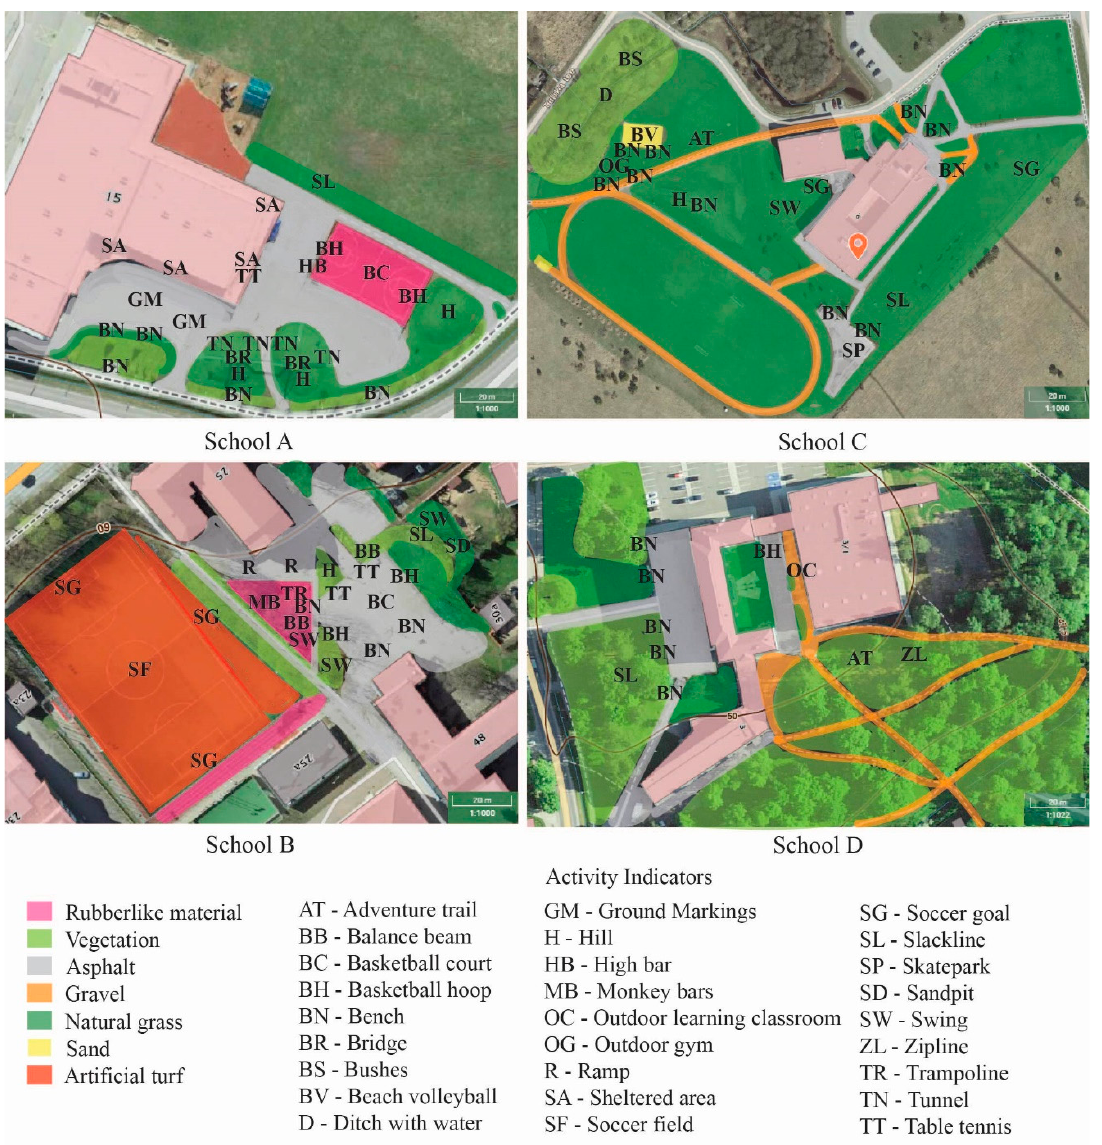
Figure 1. Schoolyards of different schools (descriptions of the schools A, B, C and D are presented in Table 1), showing the characteristics of the design and facilities.